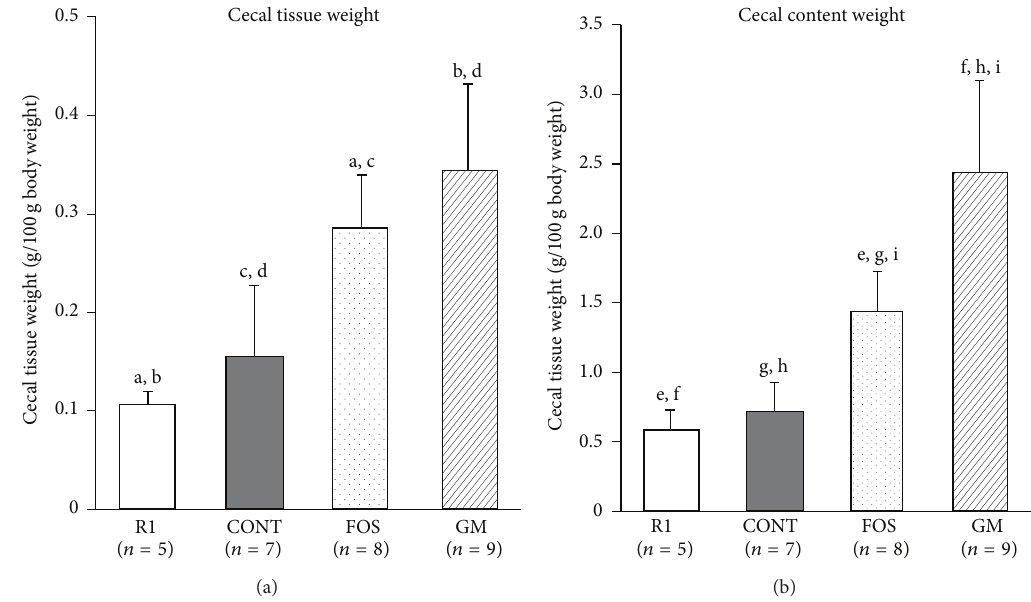
Figure 3: Weights of cecal tissue and content in SAMP8 fed diet containing FOS or GM at 38 weeks after feeding. Values were expressed as mean ± SD. R1, SAMR1, and control diet; CONT, control diet; FOS, 5% of fructooligosaccharide diet; GM, 5% of glucomannan diet. a–i: significant differences were evaluated by ANOVA and same superscripts were significantly different by Tukey’s post hoc test, at 𝑃 < 0.05 .